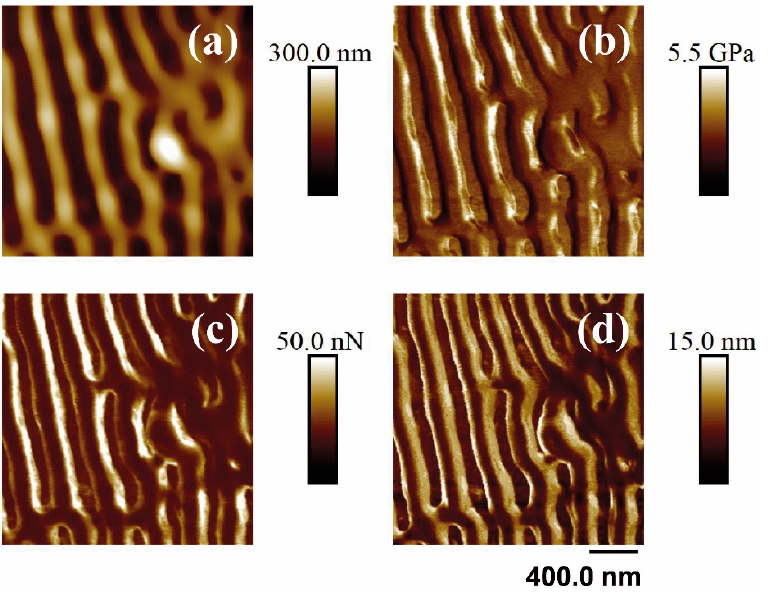
Figure 8. PF-QNM-AFM (2 × 2 µ m 2 ) mapping of the topography ( a ), Young’s module ( b ), adhesion force ( c ), and deformation ( d ) corresponding to the surface supported in unirradiated and irradiated PET silicon. The irradiation parameters were 5000 pulses, 13.8 mJ/cm 2 , 265 nm.